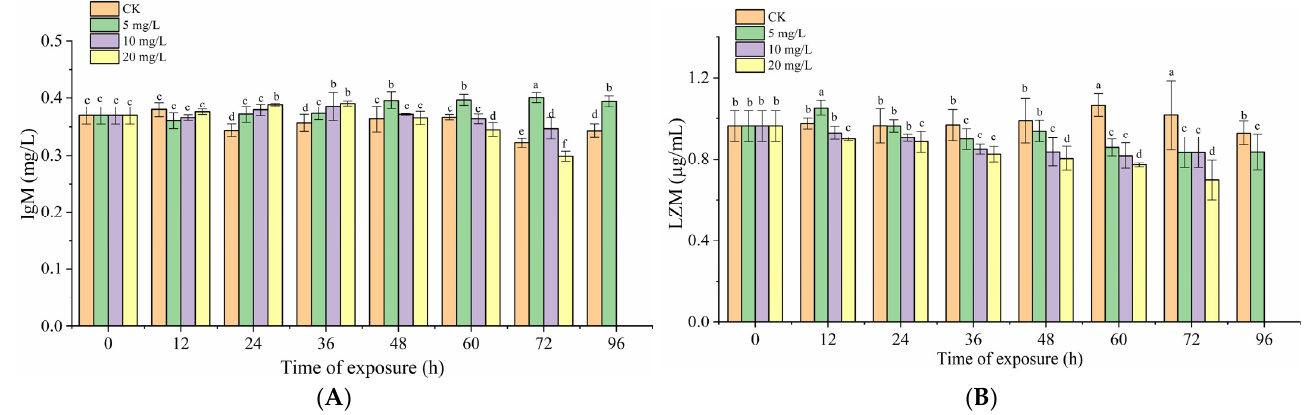
Figure 2. Changes in humoral immune parameter ( A ) IgM and ( B ) LZM levels in pearl gentian grouper exposed to various nitrite concentrations over 96 h. Data are means ± SD. Different lowercase letters indicate that there are significant differences among groups ( p < 0.05).